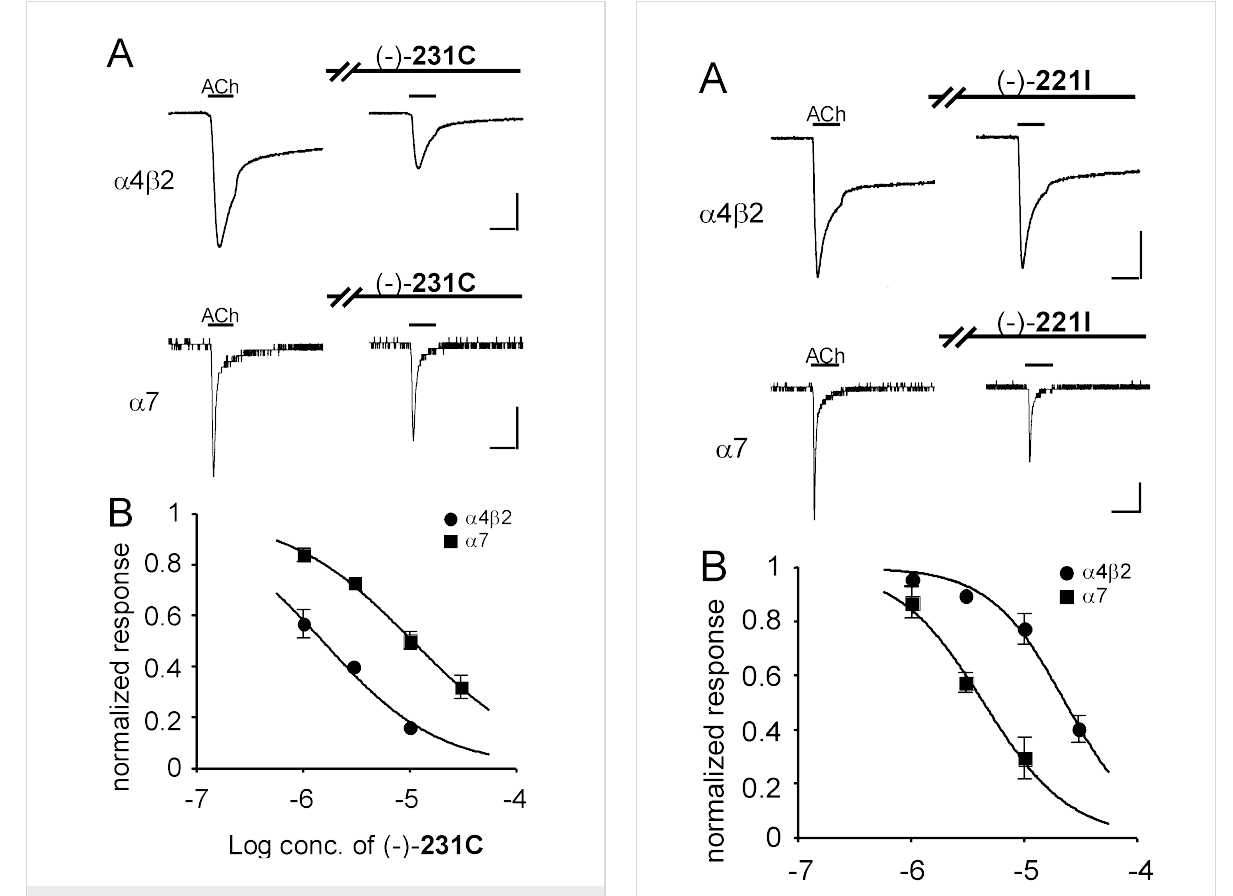
Figure 1: Inhibitory effect of (-)- 231C on ACh-induced currents in X. laevis oocytes expressing recombinant nicotinic receptors. Currents were recorded in the voltage-clamp mode at -60 mV. Concentrations of ACh used were 1 μM for the α4β2 receptor and 100 μM for the α7 receptor. For test responses, oocytes were preincubated with (-)- 231C for 3 min and then exposed to ACh with (-)- 231C . A, representative traces showing the ACh-elicited currents in the absence and presence of (-)- 231C (3 μM). Horizontal bars indicate the period of perfusion with ACh for 5 s. Vertical scale bars represent 0.5 μA on the α4β2 receptor, and 0.1 μA on the α7 receptor. B, concentration-response curves for (-)- 231C on recombinant nicotinic receptors. Current responses to ACh in the presence of (-)- 231C in each oocyte were normalized to the ACh responses (control responses) recorded in the same oocytes. Values represent the mean ± S.E.M. for five to six separate experiments.